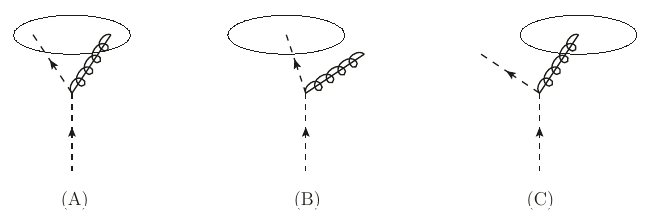
Figure 2 . The three con(cid:12)gurations that enter for the quark semi-inclusive jet function at O ( (cid:11) s ): (A) the quark and gluon are inside the jet, (B) only the quark is inside the jet, (C) only the gluon is inside the